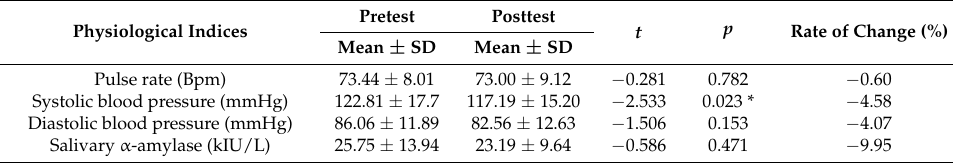
Table 3. Effect of the forest therapy program on physiological stress indices. Physiological